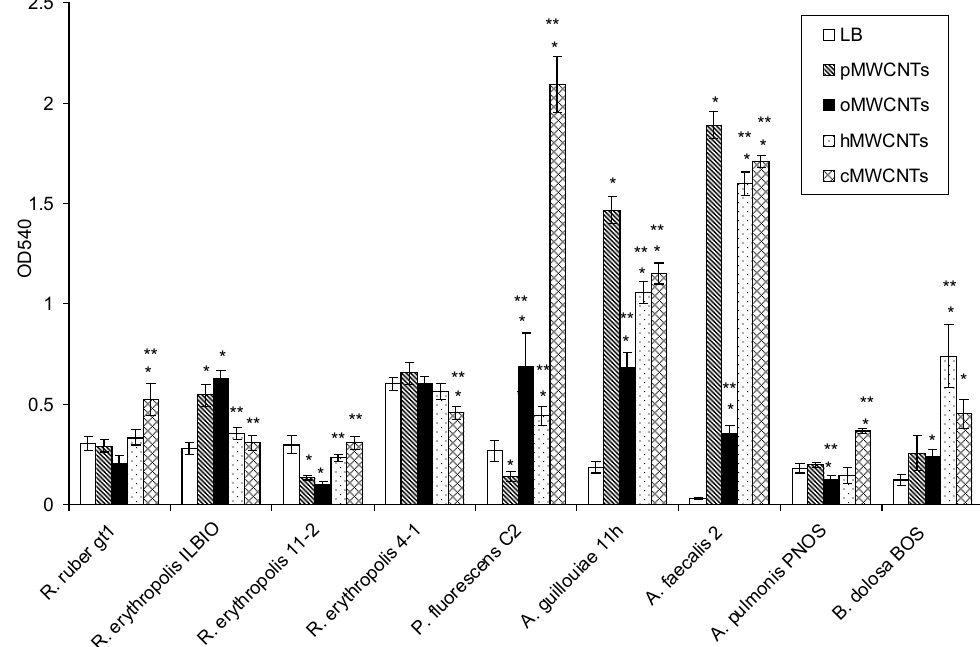
Figure 1. Biofilm formation on the medium: LB, LB with pMWCNTs, oMWCNTs, hMWCNTs, cMWCNTs. * Difference between biofilm formation on LB and LB with CNTs, p < 0.05; ** difference between biofilm formation on LB with pMWCNTs and LB with functionalized MWCNTs, p <